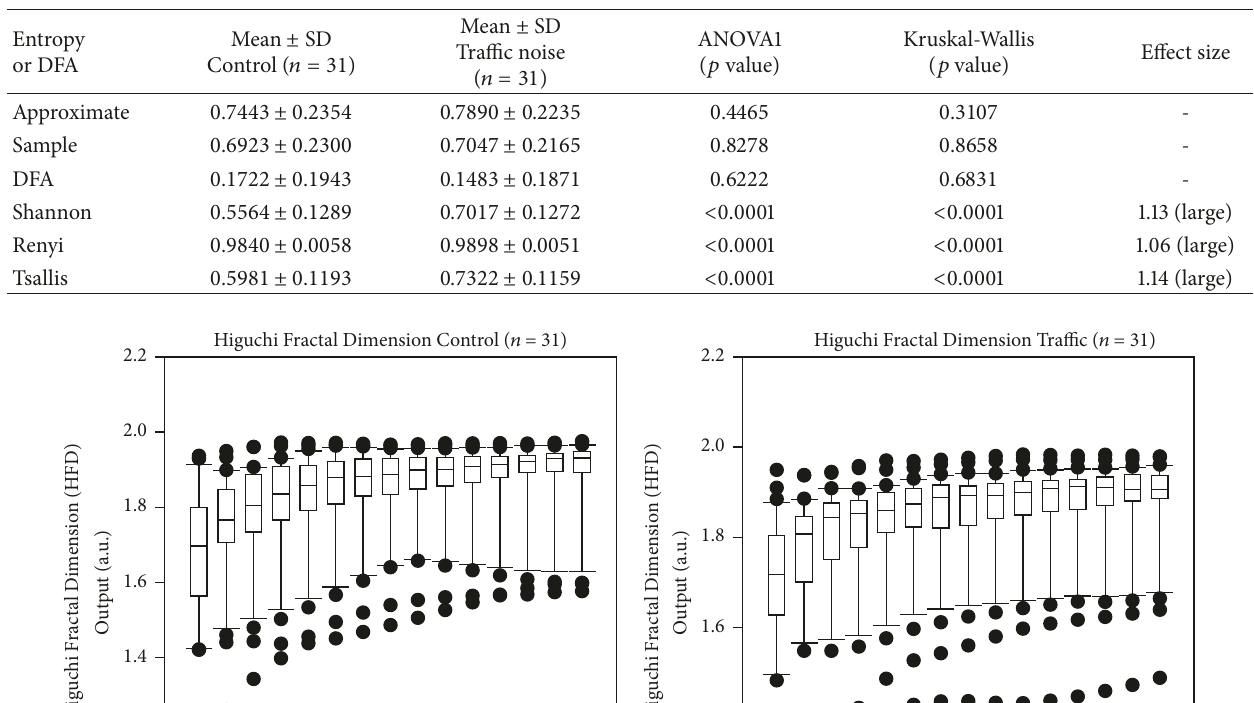
healthy men and women and also noted increased values of the LF/HF ratio during noise exposure, indicating increased sympathetic control of heart